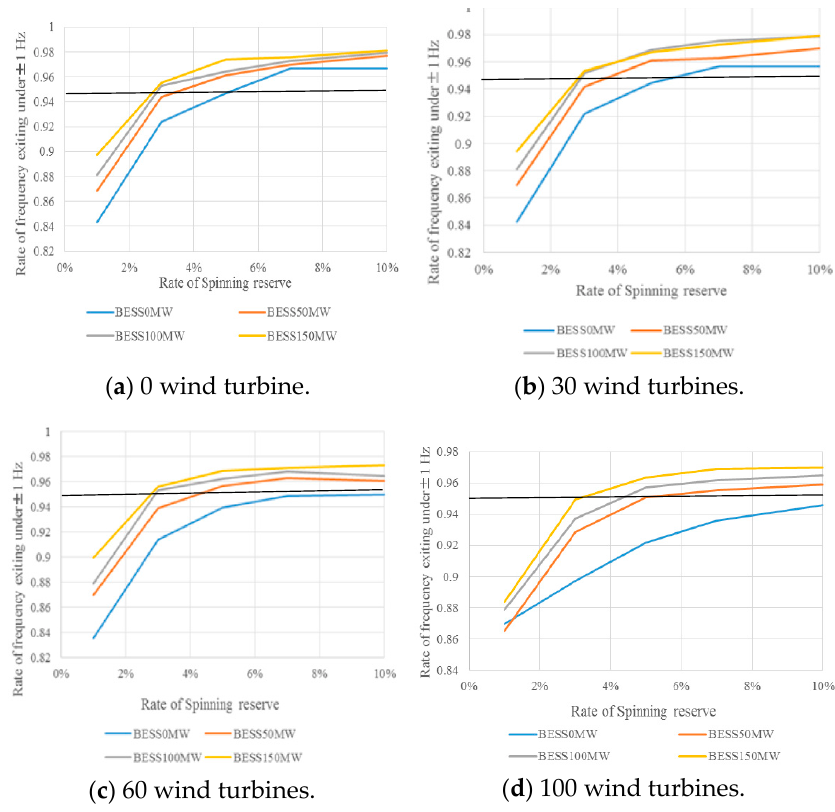
Figure 11. Rate of frequency under ±1 of 10 m/s wind turbine.